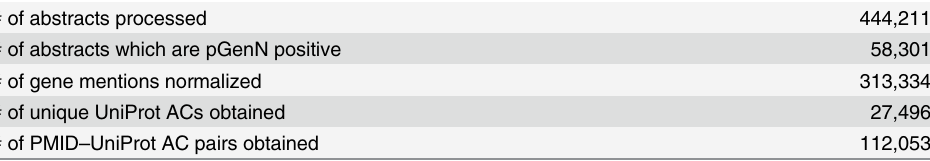
Table 7. Statistics of pGenN large-scale processing of plant Medline